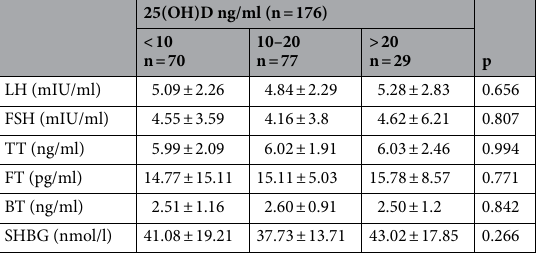
Table 2. Adjusted mean (s.e.) of hormonal parameters per status of serum vitamin D level. Adjusted for age, BMI, WHR, alcohol intake and cigarettes smoking.